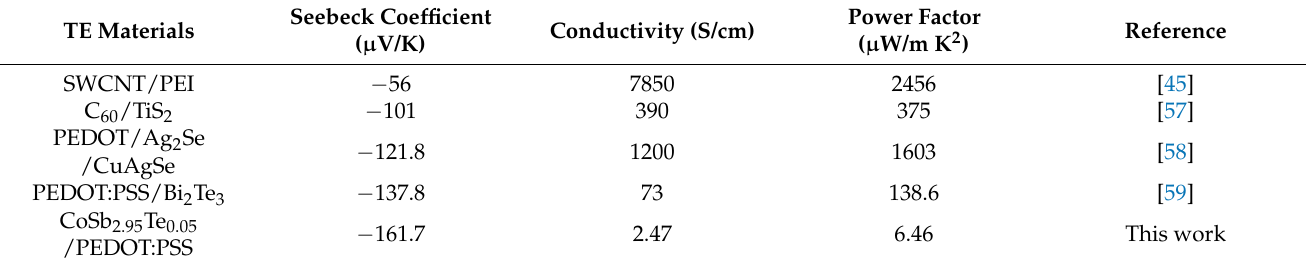
Figure 4. Thermoelectric properties of the hybrid films at room temperature as a function of the weight percentage (95, 97, and 98 wt%) of the CoSb 3-x Te x (x = 0.05, 0.10, and 0.15) in the hybrid films with PEDOT:PSS: ( a ) Seebeck coefficient, ( b ) electrical conductivity, and ( c ) power factor. Table 1. Comparison of the reported Seebeck coefficient of the n -type flexible TE devices at room temperature.